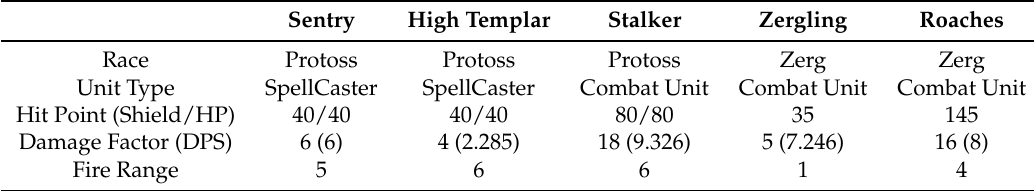
Table 1. The comparative attributes of different units in out minigame scenarios.